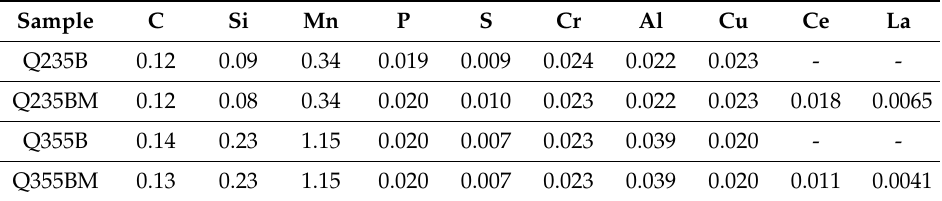
Table 1. Chemical composition of experimental steels